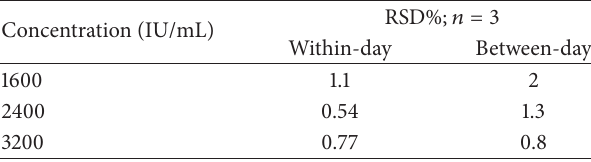
Table 2: Precision of the developed methods.